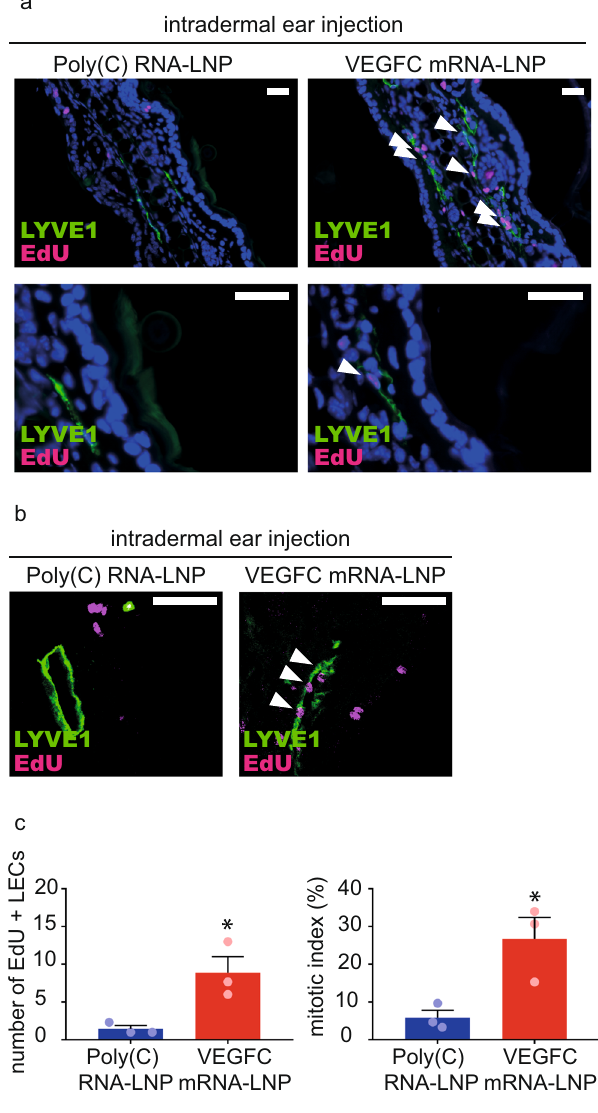
Fig. 3 Administration of VEGFC mRNA-LNPs induces local lymphatic proliferation in mice in vivo. a – b Assessment of lymphatic proliferation 5 days after intradermal injection with 1 µ g of Poly(C) or VEGFC mRNA- LNPs. EdU staining and anti-LYVE1 immunostaining of slides processed by paraf fi n-based histology (bars, 50 µ m) shown by wide fi eld ( a ) and confocal imaging ( b ). Arrows indicate EdU and LYVE1 double positive lymphatic endothelial cell (LEC) nuclei. Representative images of 3 ears of 3 mice in each group are shown. c Number of EdU positive LECs (two-tailed, unpaired T -test, P = 0.0260 for 3 mice) and mitotic index (two-tailed, unpaired T - test, P = 0.0266 for 3 mice) are shown 5 days after intradermal injection with 1 µ g of Poly(C) or VEGFC mRNA-LNPs. Quantitative data for lymphatic proliferation are represented as mean and SEM from 3 injected ears of 3 mice in each